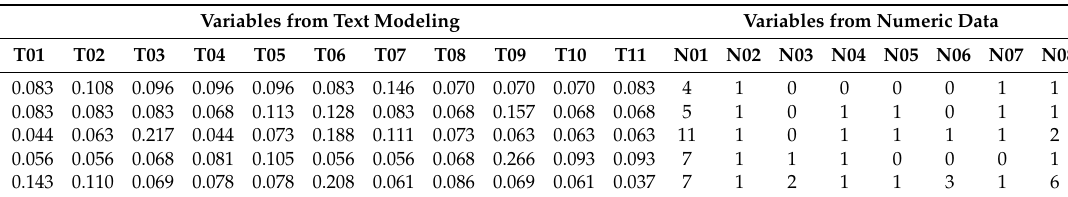
Table 2. Part of integrated data set.